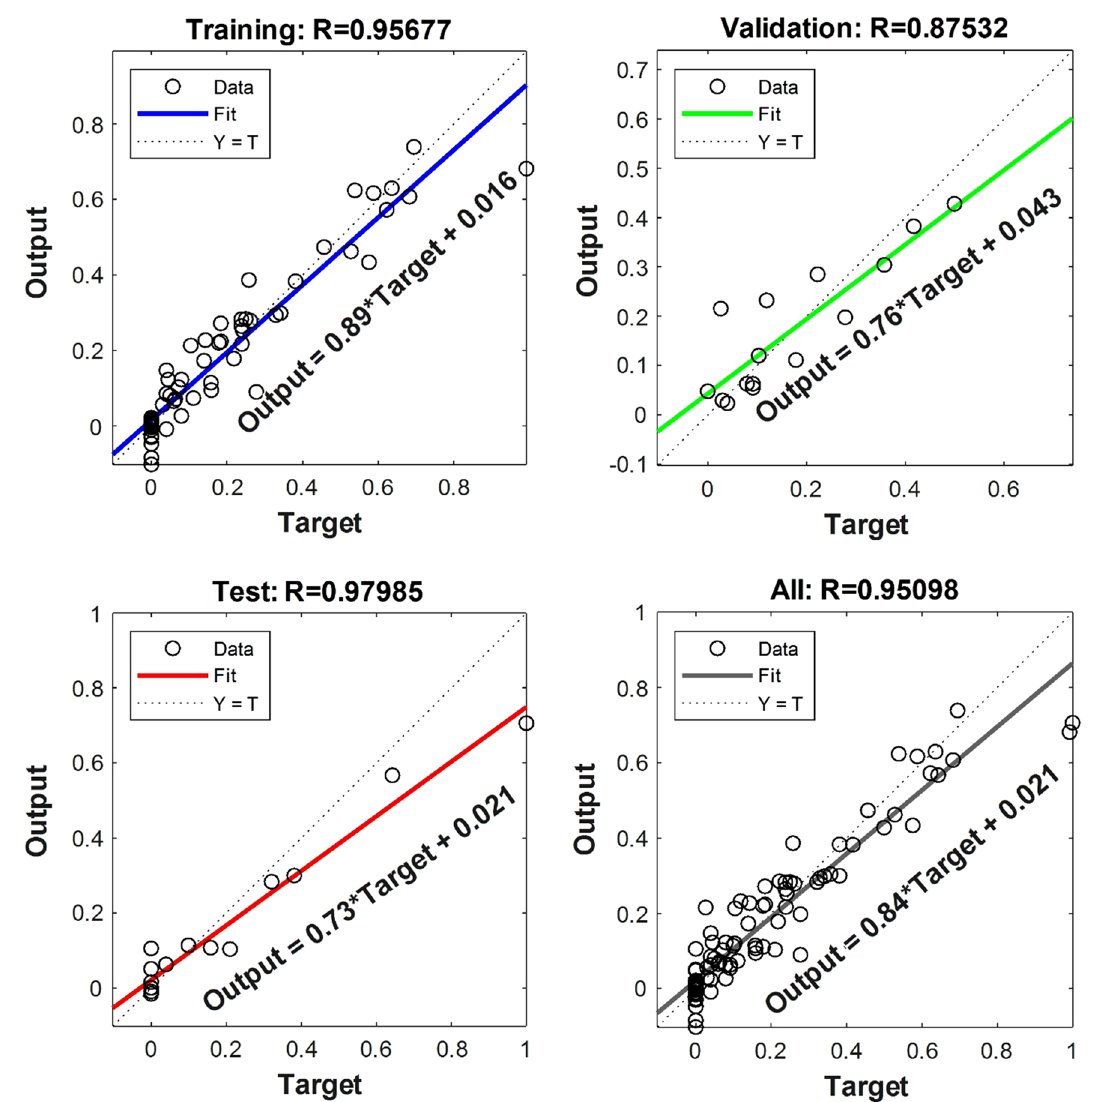
Fig. 22 The training regression of the Model No.1 (ANN 1) for liquefaction